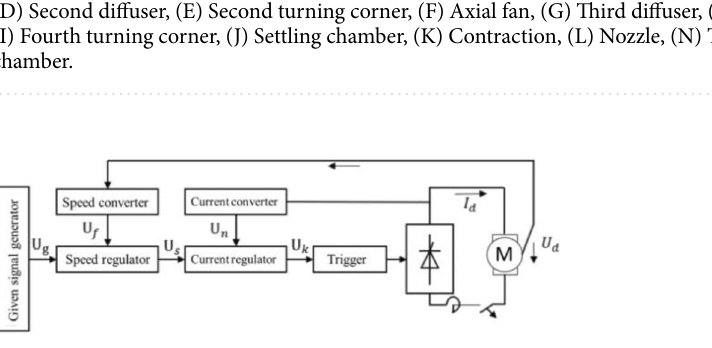
Figure 2. The dual closed loop Speed-controlled System.